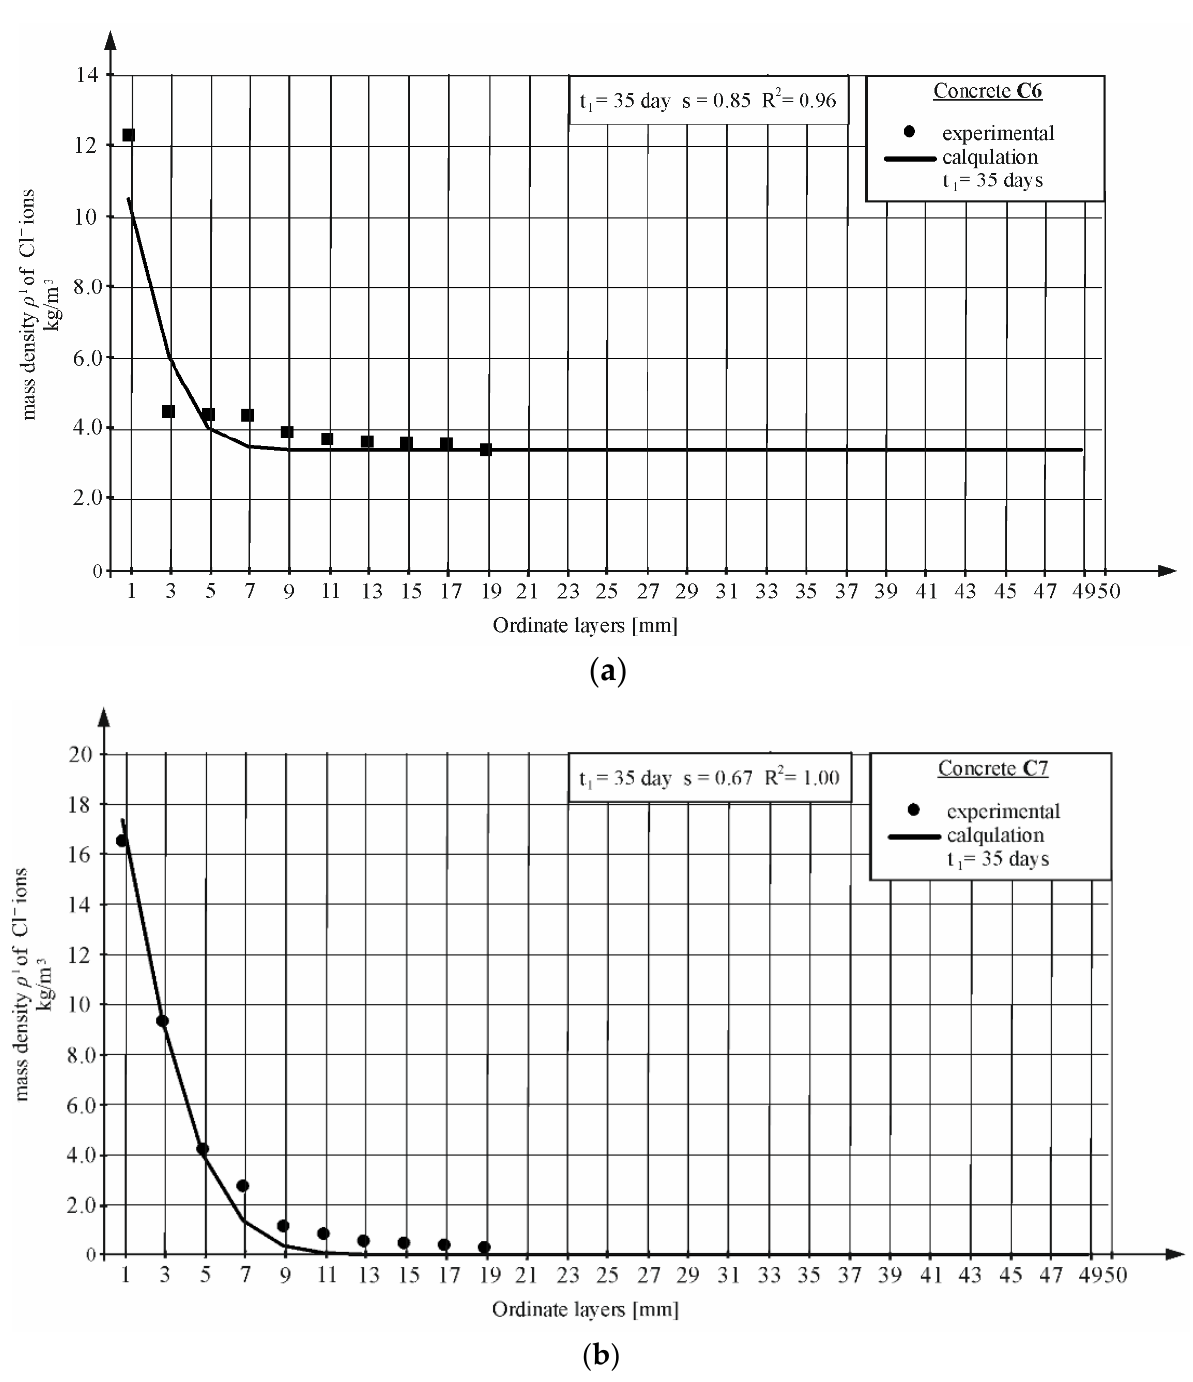
Figure 6. Chloride ion profile determined in migration tests according to NT BUILD 443 [5] and American ASTM 1556 [4] and calculated using the Equations (4) and (5). Concretes (CPT): ( a ) C6; ( b ) C7.